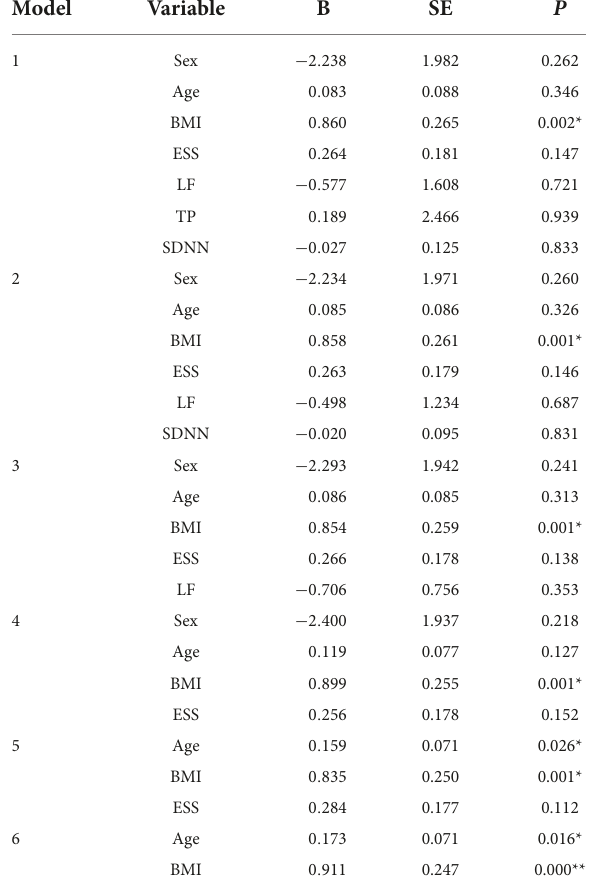
TABLE 5 Backward stepwise regression analysis of ODI with related variables in all participants.